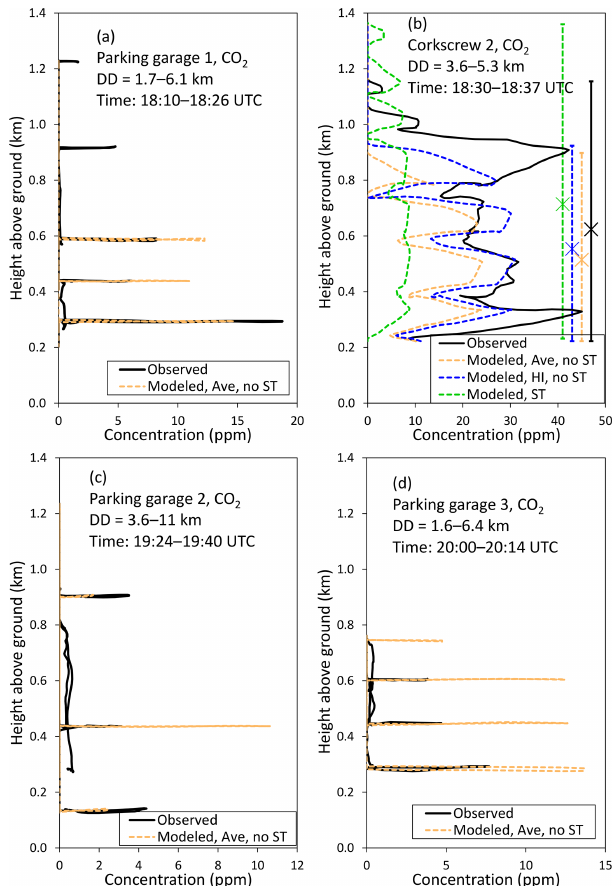
Figure 5. The vertical excess concentrations of CO 2 versus height for (a, c, d) three parking garage maneuvers and (b) the second corkscrew flight maneuver. The curves represent observed data (solid black), modeled base case (dashed orange), modeled values using the input data during the high-intensity (HI) phase of the fire (dashed blue), and modeled values for the base case, including the source term (ST) module (dashed green). In panel (b) , the observed and modeled vertical extents of plume are also shown as vertical bars on the right-hand side. The centers of mass of the plumes are marked with crosshairs. Notation: DD – the downwind distance from the center of the L2F burn block, time – the time interval of the maneuver of the measurement aircraft, UTC – Coordinated Uni- versal